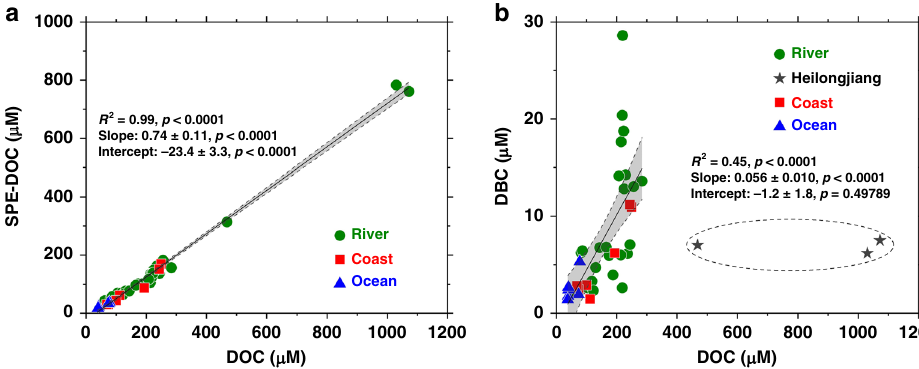
Fig. 3 Correlations of SPE-DOC and DBC with DOC. a Concentrations of SPE-DOC vs. DOC for all samples determined ( n = 40, R 2 = 0.99, p < 0.0001); and b concentrations of DBC vs. DOC for the samples ( n = 37, R 2 = 0.45, p < 0.0001, Heilongjiang data were not included) (DOC dissolved organic carbon, SPE-DOC solid phase extracted dissolved organic carbon, DBC dissolved black carbon). The statistics are for the regression of the average values. The gray areas show the 95% con fi dence interval of the linear regression. We applied one-sided F test and two-sided t test, and the calculated p values as